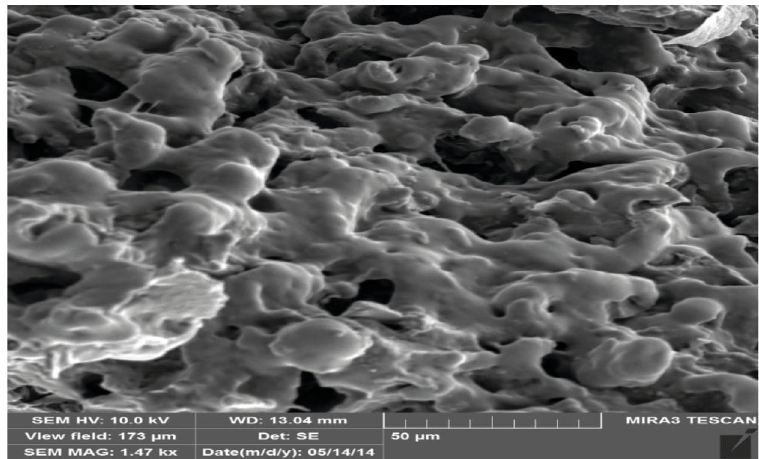
Figure 10: Scanning electron micrographs of DPWF after grafting, SEM MAG (1.47 KX).